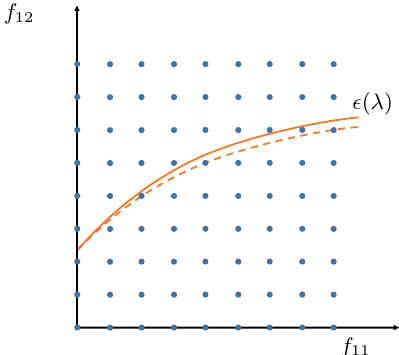
Figure 6 . 2d slice of the (cid:13)ux lattice and the surface traced out by the free parameters (cid:21) i before and after adjusting the moduli